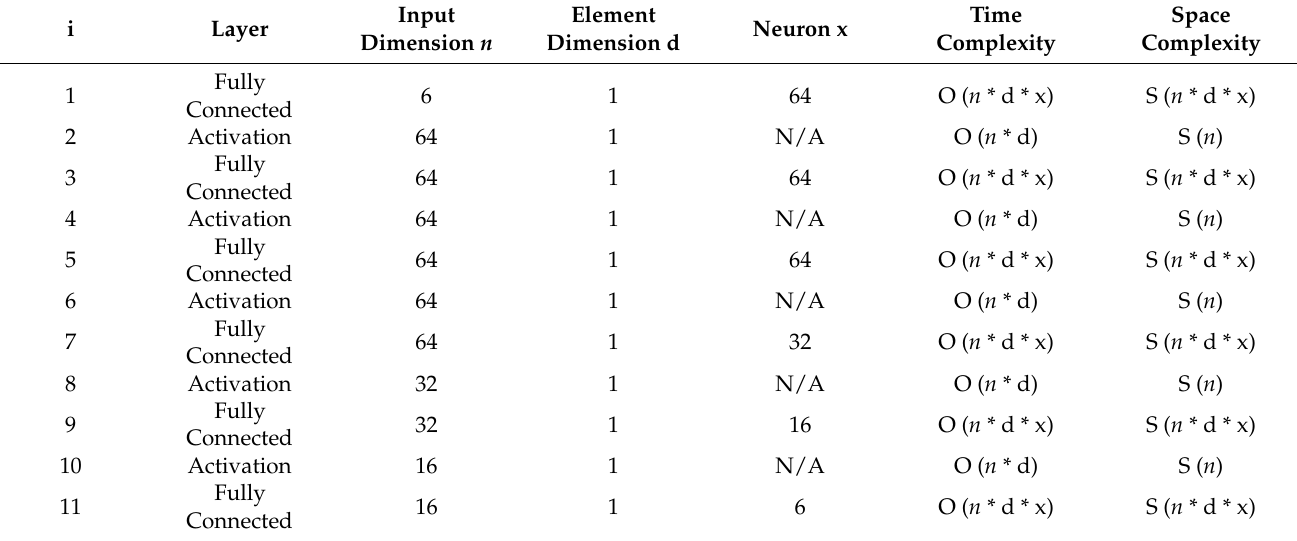
Table 2. Forward kinematics complexity